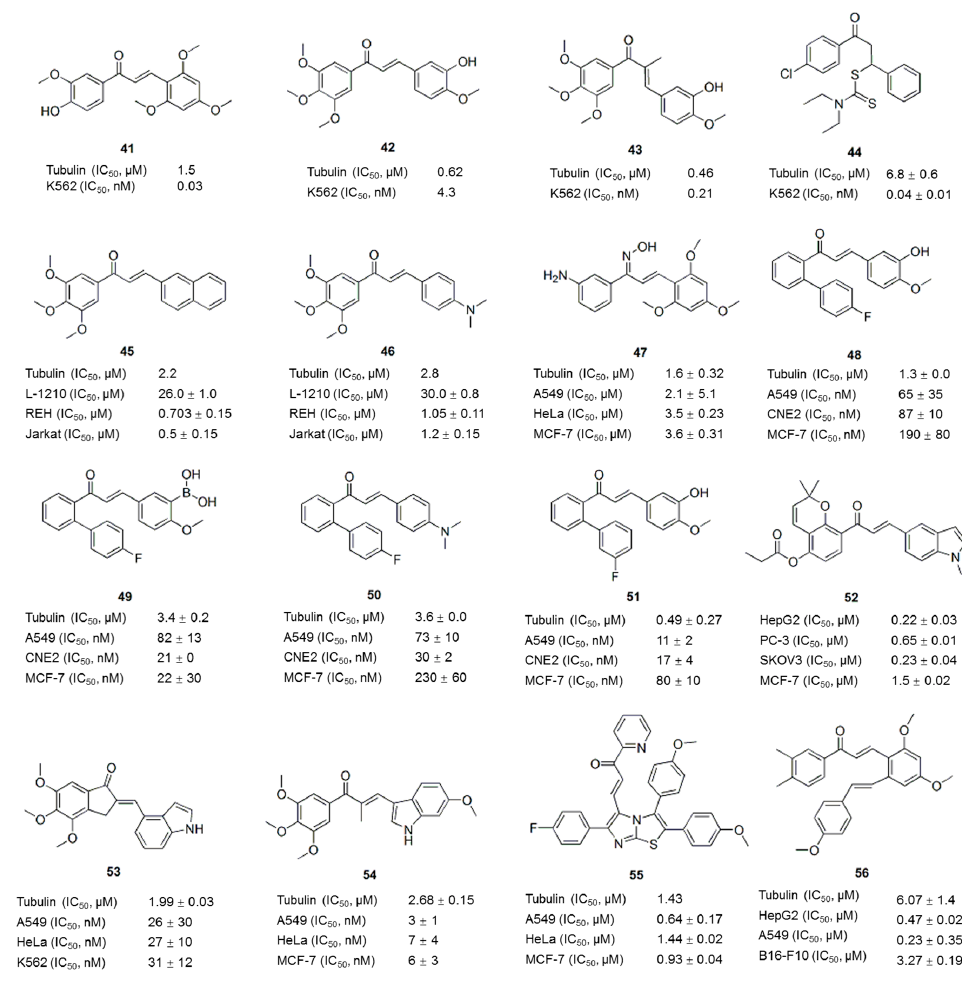
Figure 6. Chalcone analogues.